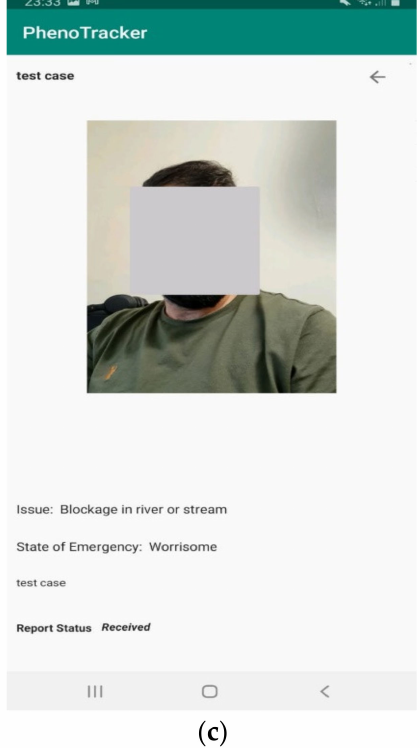
Figure 7. ( a ) List of reports, appearing in the nearest location first order. Factors covered: Sense of Community, Social Bonds, Curiosity Drive and Situatedness. ( b ) Exhaustive report search. Factors covered: Situatedness. ( c ) Face masking and Report status update. Factors covered: Trust and